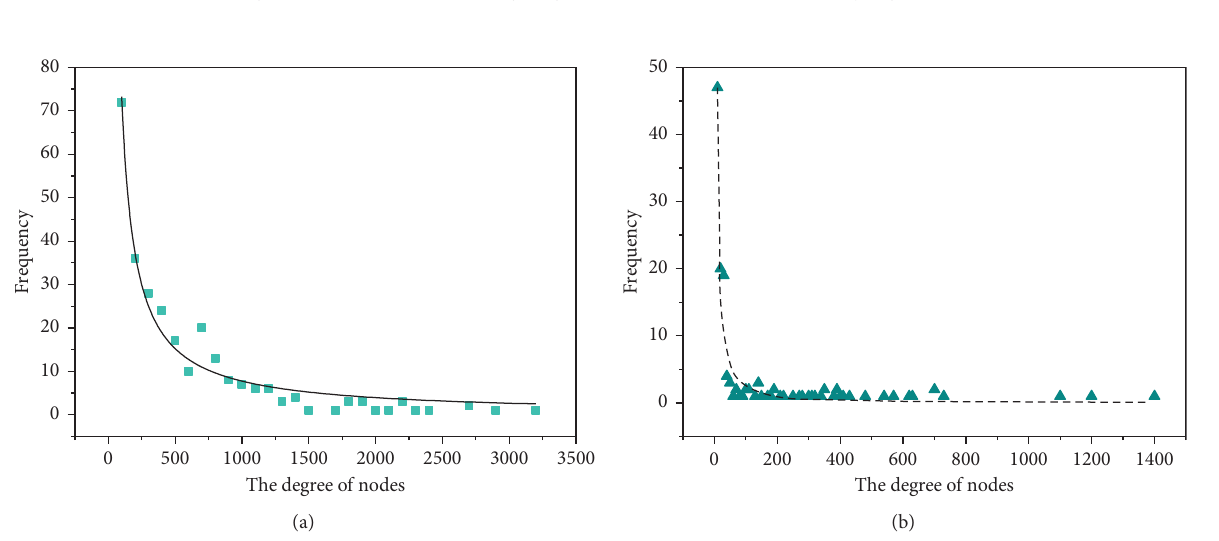
Figure 5: Node degree distribution of China railway and air transport networks. (a) Railway network. (b) Air transport